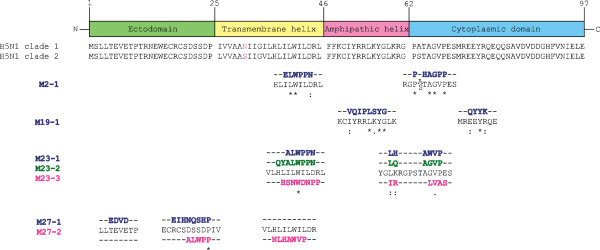
Phage peptide sequences matched with residues of A/H5N1 monomeric M2 molecule (epitopes of HuScFv). HuScFv2 mimotope type (M2-1: ELWPPNPHAGPP) matched with amino acid residues in transmembrane helix and cytoplasmic C-terminal of M2 of both viruses; HuScFv19 mimotope type (M19-1: VQIPLSYGQYYK) matched with residues of the M2 amphipathic helix and cytoplasmic C-terminal; HuScFv23 mimotope types (M23-1:ALWPPNLHAWVP, M23-2: QYALWPPNLQAGVP, M23-3: HSNWDNPPIRLVAS) matched with residues in transmembrane domain, amphipathic helix and cytoplasmic C-terminal; mimotope types of HuScFv27 (M27-: EDVDEIHNQSHP and M27-2: ALWPPNLHANVP) matched with M2 residues in ectodomain and transmembrane helix.